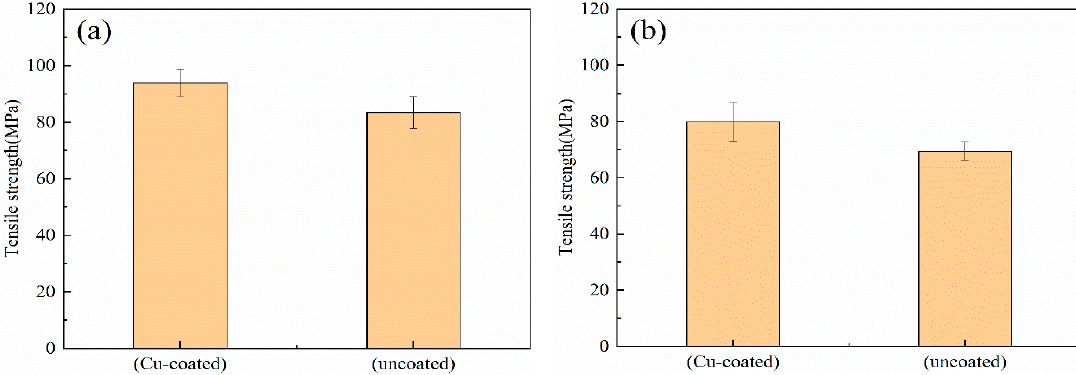
Figure 12. Tensile strength of different materials: ( a ) braided carbon fiber rope; ( b ) carbon fiber bundle.